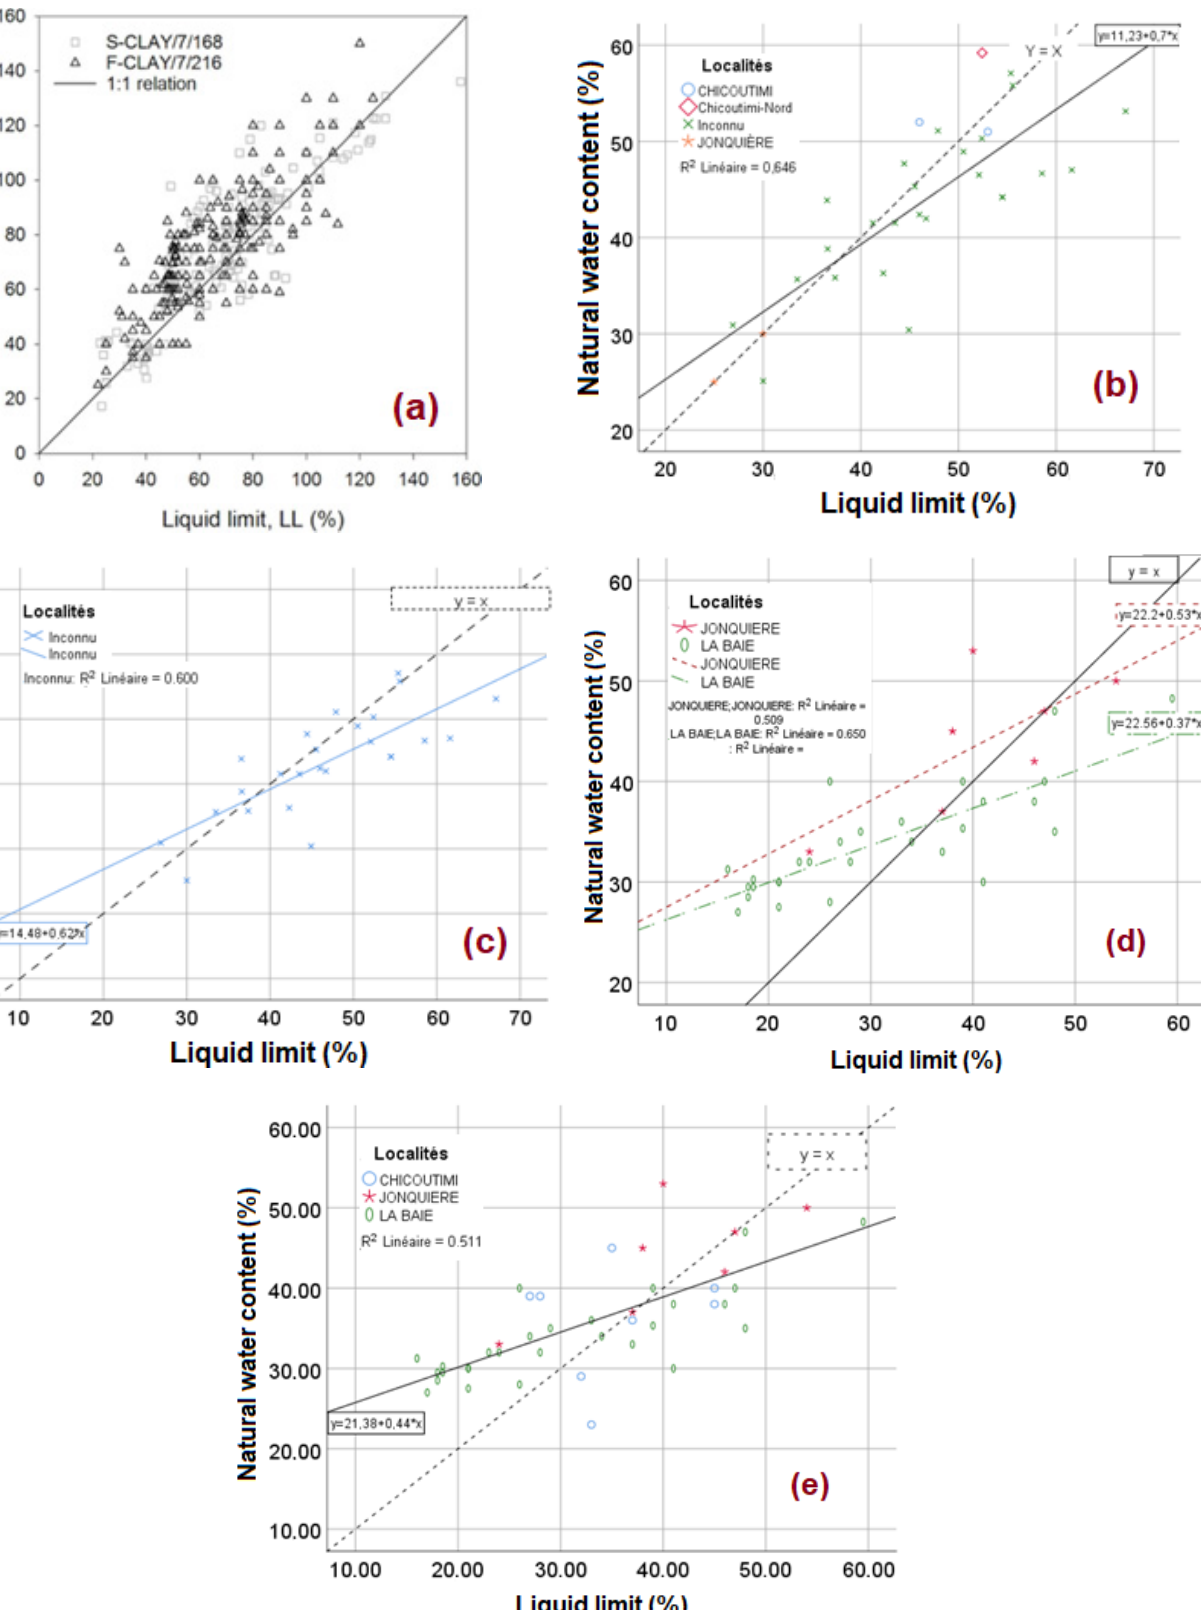
Figure 14. Linear relationship between water content and liquid limit for ( a ) Swedish and Finnish clay samples [20]; ( b ) SLSJ clay samples; ( c ) SLSJ clay samples (unknown localities); ( d ) SLSJ silt samples; ( e ) SLSJ silt samples from different localities.